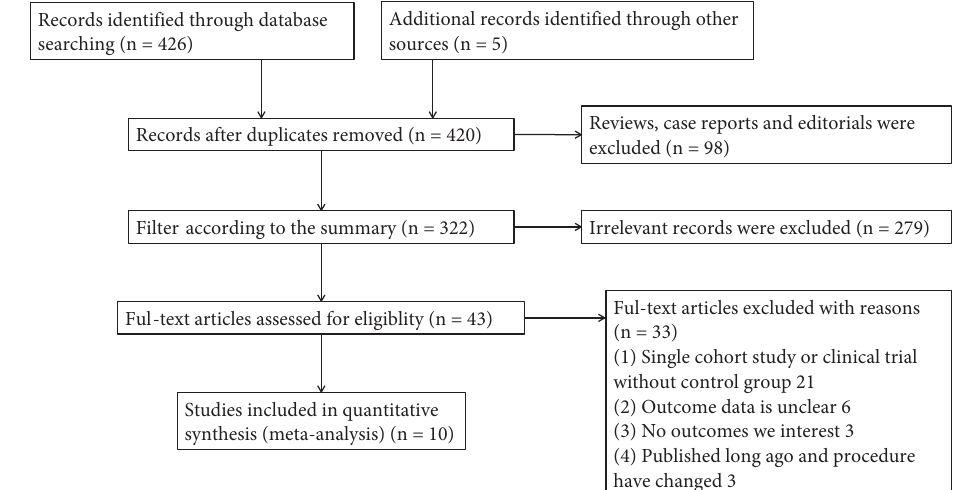
Figure 1: Flow diagram for study identification and inclusion. Table 2: Summary of included